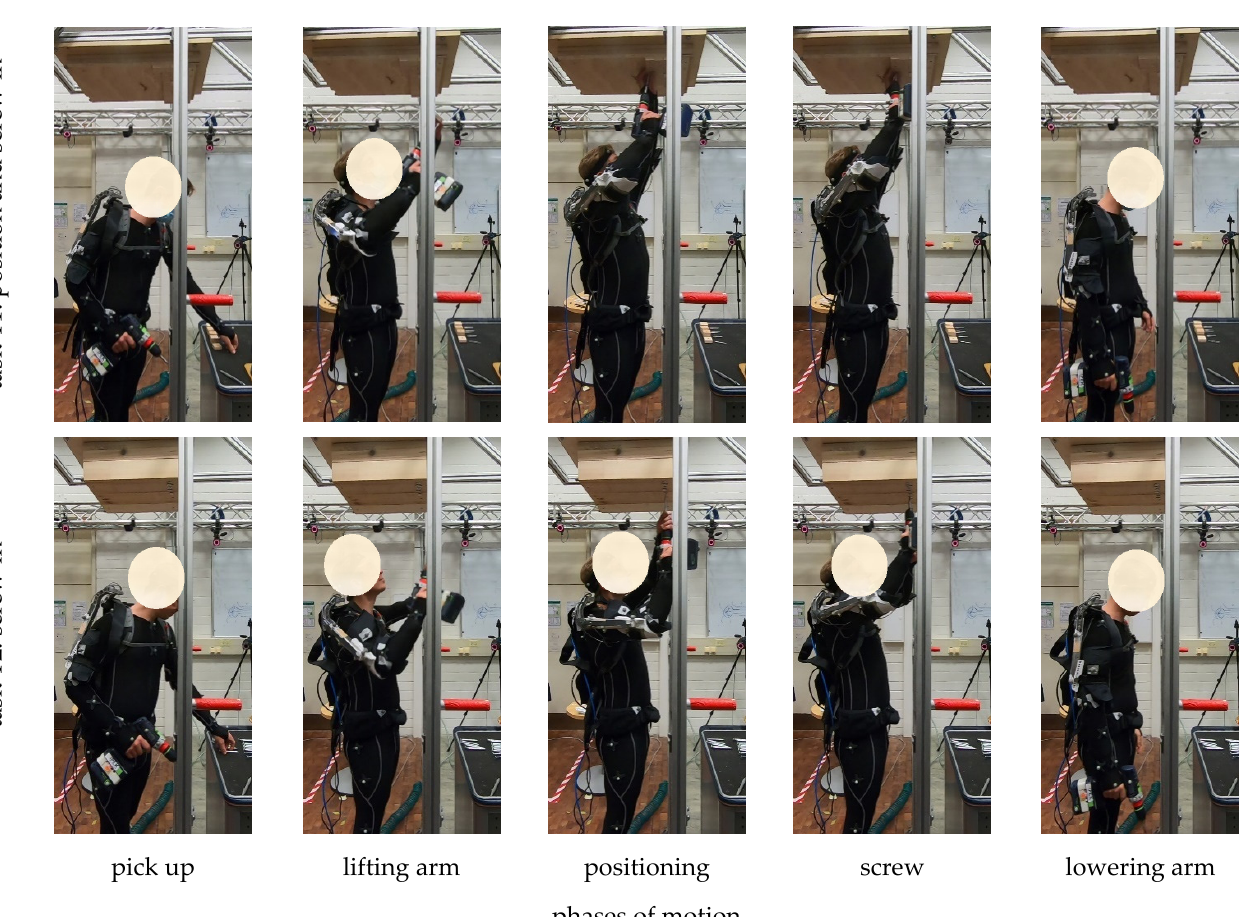
Figure 3. The definition of one motion cycle and its motion